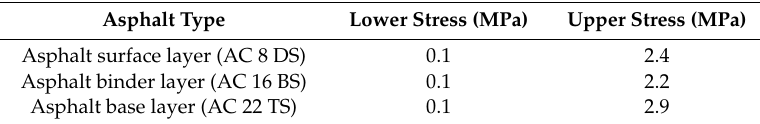
Table 3. Lower and upper stresses in the dynamic 3PSCBT.